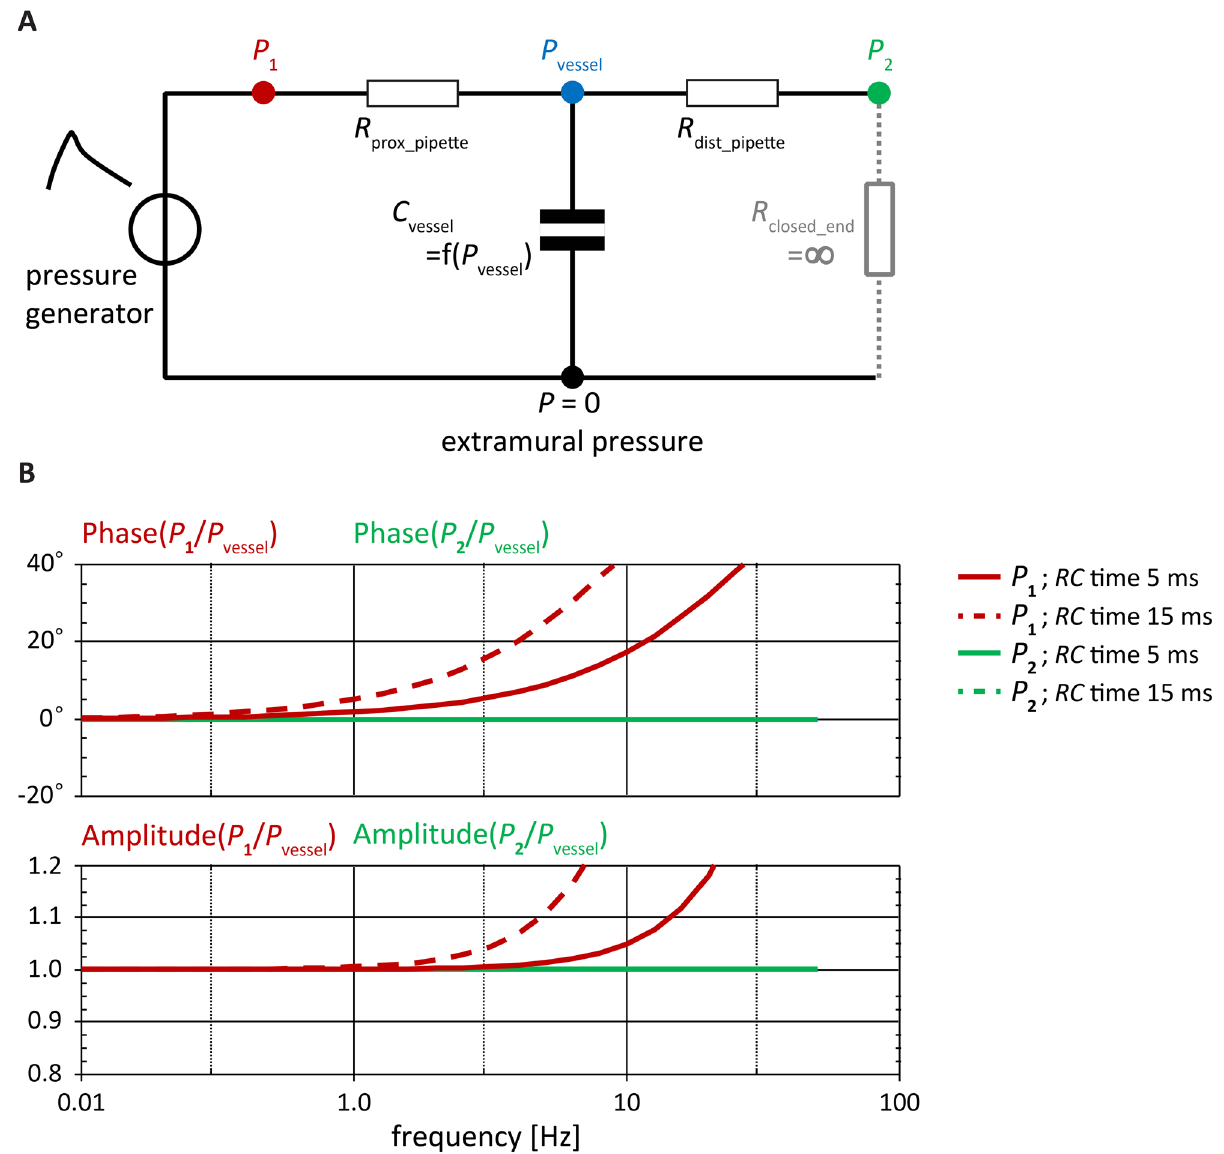
Figure 2. ( A ) Schematic model of the pipette configuration and pressure recording positions. P 1 indicates the proximal pressure sensor; P 2 indicates the distal pressure sensor; and P vessel indicates the true pressure inside the vessel under test. R closed_end models the stopcock distal to sensor P 2 which during measurements is closed to prevent any flow through the distal pipette (modelled by R dist_pipette ). We used the “ C vessel = f ( P vessel )” notation to indicate that C vessel is strongly dependent on transmural pressure (due to nonlinear arterial elasticity). ( B ) Phase (top) and amplitude (bottom) bode diagrams, showing amplitude relationships of P 2 and P 1 to P vessel , as a function of frequency. A phase of zero degrees indicates no phase error; an amplitude of 1.0 indicates no amplitude error. Continuous lines indicate the situation for an RC -time (defined as R prox_pipette ∙ C vessel ) of about 5 ms and the dashed lines for a tripled RC -time (i.e. 15 ms, with C vessel assumed 3 times larger and R prox_pipette kept constant). P 1 shows considerable, frequency-dependent errors, whereas P 2 shows flat curves with no errors in the relevant frequency range (i.e. 5 Hz cycle times 10 harmonics to represent the waveform requires at least 50 Hz). Taken together, pressure as recorded at P 2 is representative of P vessel . In contrast, P 1 shows a large, frequency and compliance-dependent difference (error) from P vessel 50 Hz (i.e. 10 harmonics at a base frequency of 5 Hz). Hence, if P 1 would be used to represent P vessel , a substantial overestimation and phase error would occur at frequencies within this relevant bandwidth. When using P 2 to represent P vessel , these problems are negligible.